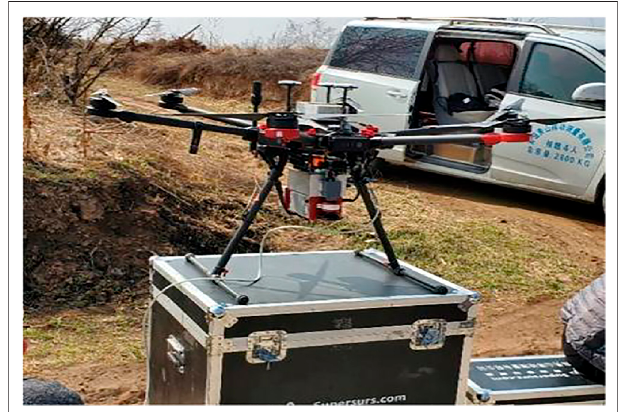
FIGURE 3 | UAV 3D laser scanning system.